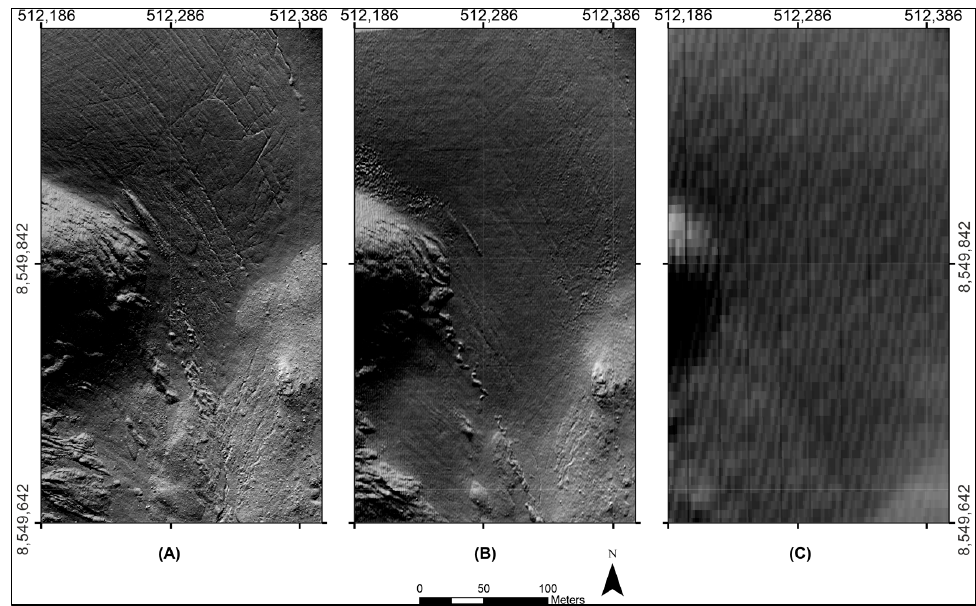
Figure 6. Comparison of the three DEMs: ( A ) drone from June 2022, ( B ) SIOS from July 2020, and ( C ) ArcticDEM from July 2018 in Ariebreen forefield (note the retreat of the glacier and the exposed outwash plain).